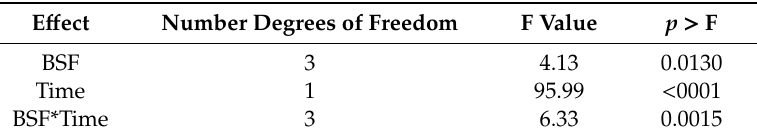
Table 3. Test of fixed effects of total coliforms.